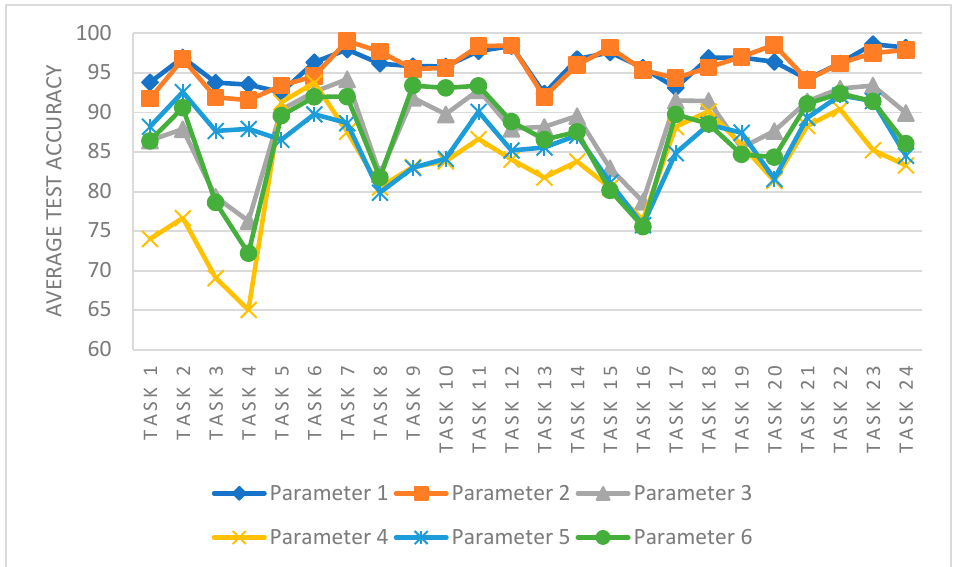
Figure 9. The influence of different parameter settings on the DCNG model in the CWRU data set.